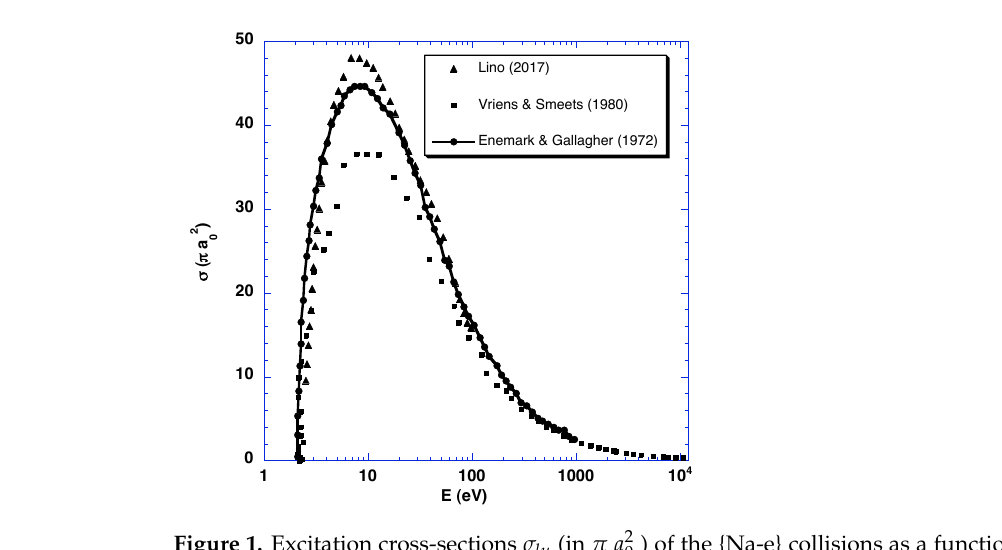
) of the {Na-e} collisions as a function of the kinetic 0